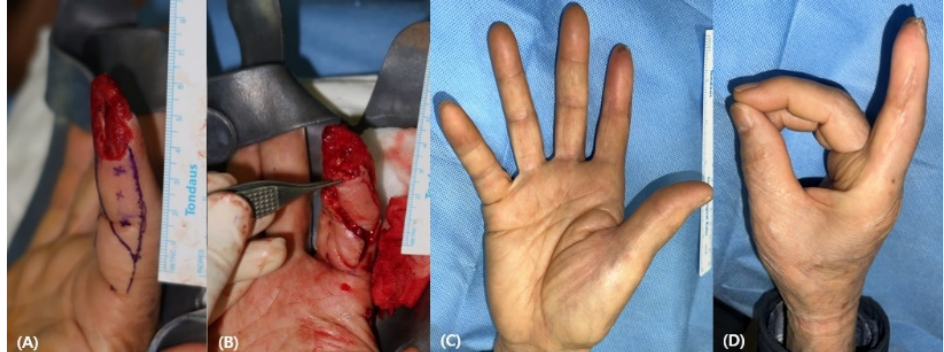
Figure 5. ( A ) 51-year-old man experienced a crush injury to the right second finger above the lunula. ( B ) A 3.5 cm × 1.5 cm-sized homodigital neurovascular island flap was elevated and transposed to the defect. ( C , D ) Postoperative photographic findings 6 months after the operation.